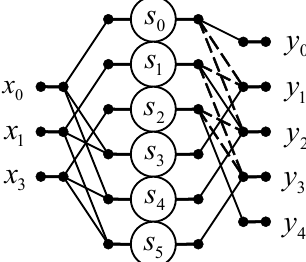
Figure 2. The signal flow graph of the proposed algorithm for computation of 3-point linear